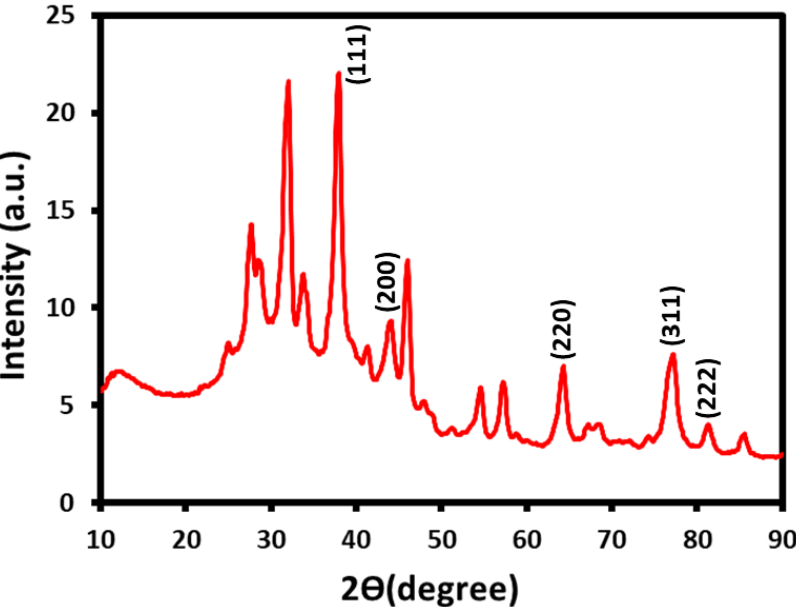
Figure 2. X-ray diffraction (XRD) diffractogram of as-synthesized silver nanoparticles (AP-AgNPs).